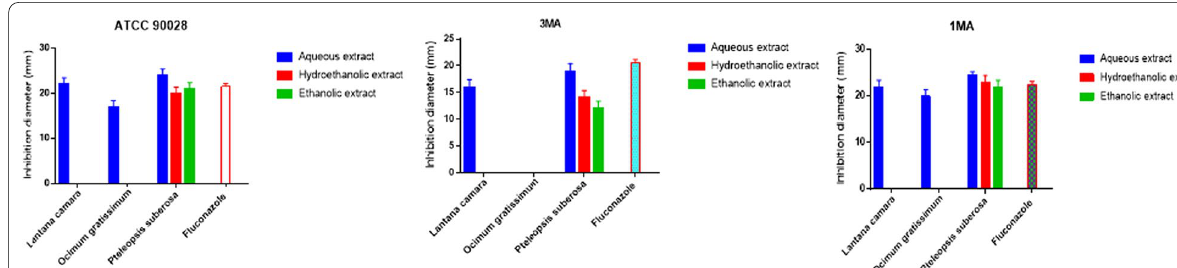
Fig. 2 In vitro antifungal activity of plant extracts on the tested strains